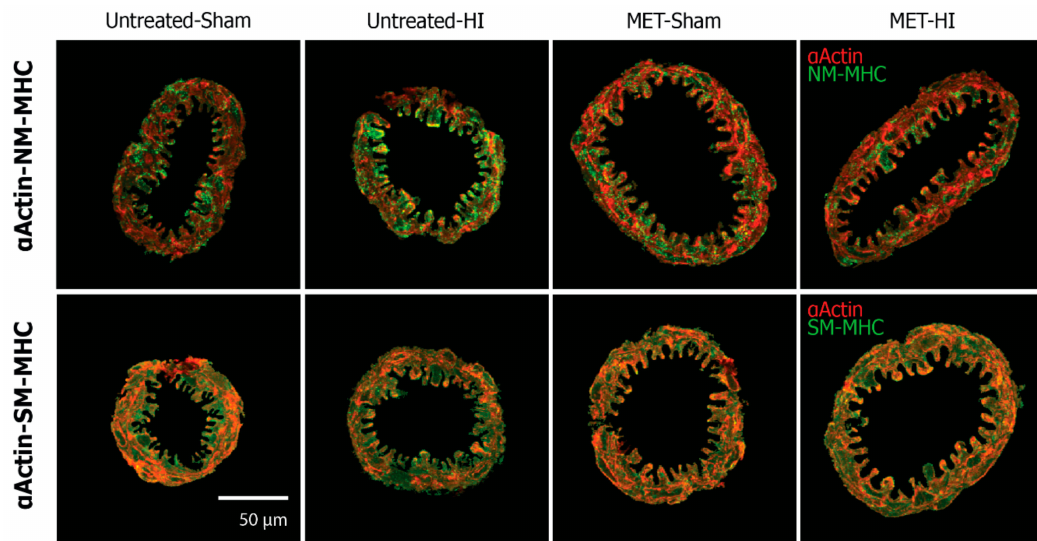
Figure 3. Effects of HI and gestational MET on Confocal Colocalization of Smooth Muscle Contractile Proteins in MUN Arteries. The images shown originated from middle cerebral arteries stained for smooth muscle α actin ( α Actin) and non-muscle myosin heavy chain (NM-MHC) on the top panel or α actin and smooth muscle MHC (SM-MHC) on the bottom panel from each of the four MUN treatment